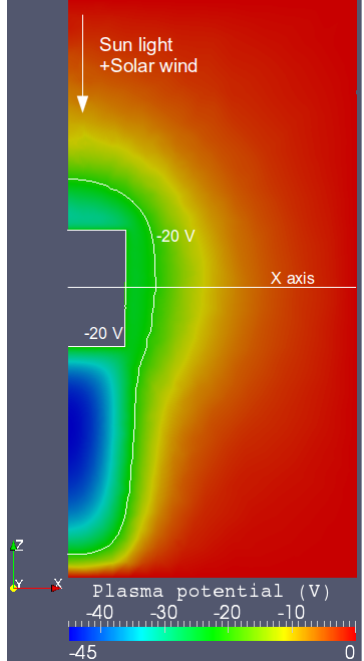
Fig. 5. Cross comparison simulation B (SPIS): Plasma potential in a X = 0